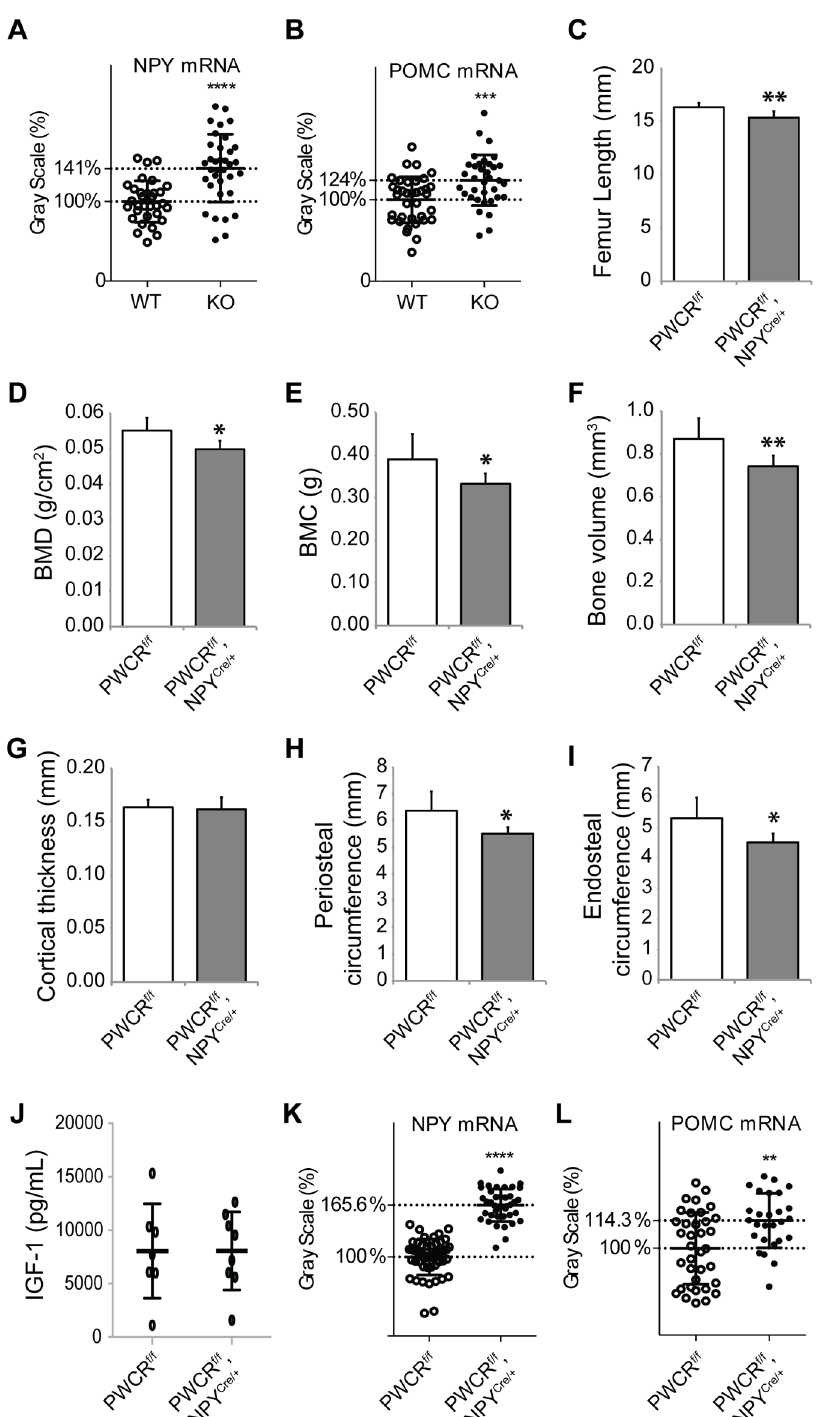
Fig 6. Selective deletion of PWCR only in NPY neurons. In situ hybridisation for A.) NPY and B.) POMC expressions in arcuate nucleus of WT and PWCR KO mice. Bone phenotype analysis of PWCR f/f , NPY Cre/+ and PWCR f/f control mice: C.) femur length; D.) whole body BMD; E.) whole body BMC measured by DXA; F.) cortical bone volume; G.) cortical thickness; H.) periosteal circumference and I.) endosteal circumference measured by μ CT. n = 6 – 8 represented as mean ± SD using 16 week old male mice. J.) Serum IGF-1 levels and in situ hybridisation for K.) NPY and L.) POMC in the arcuate nucleus of PWCR f/f , NPY Cre/+ and PWCR